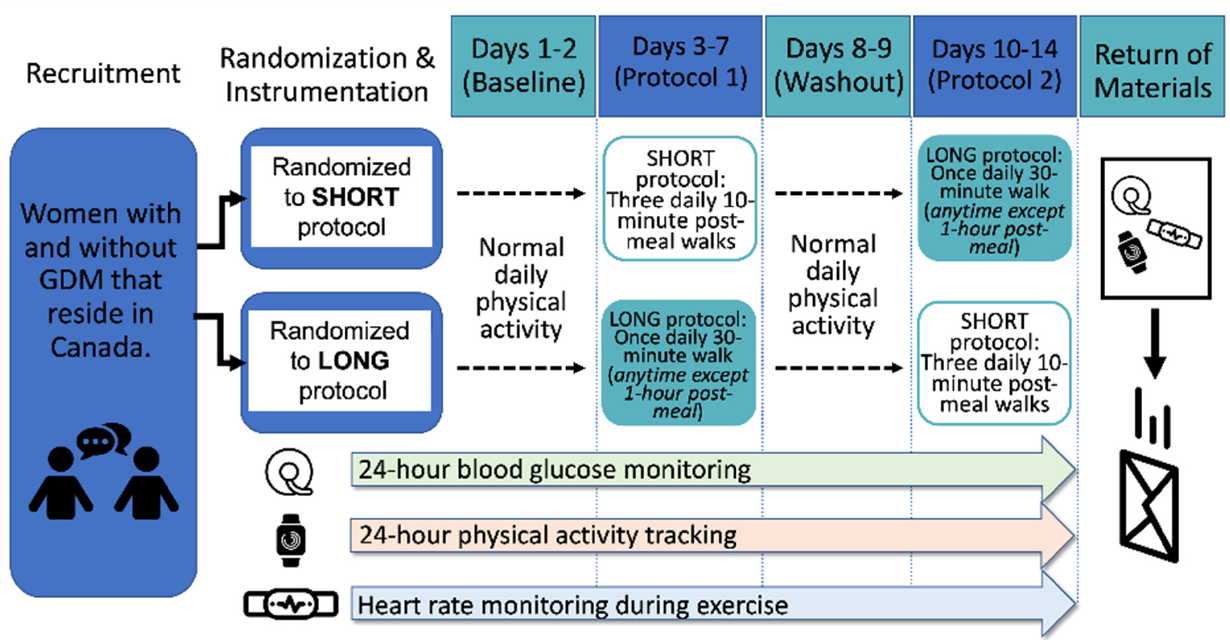
Figure 1. Study design schematic.